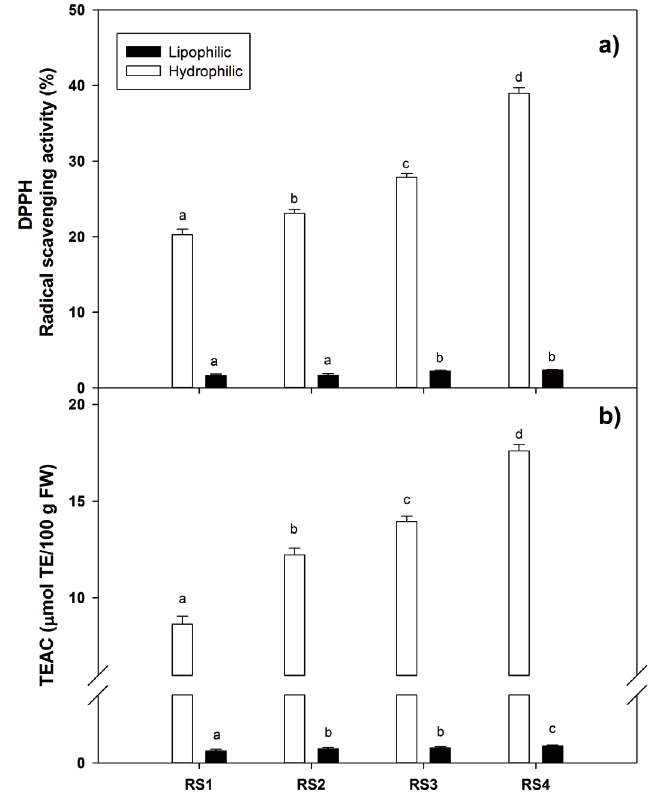
Fig. 3: Antioxidant capacity of hydrophilic and lipophilic extracts of pine- apple cv. Esmeralda at four ripening stages (RS). (a) DPPH and (b) TEAC. Different letters indicate significant differences (p < 0.05), n